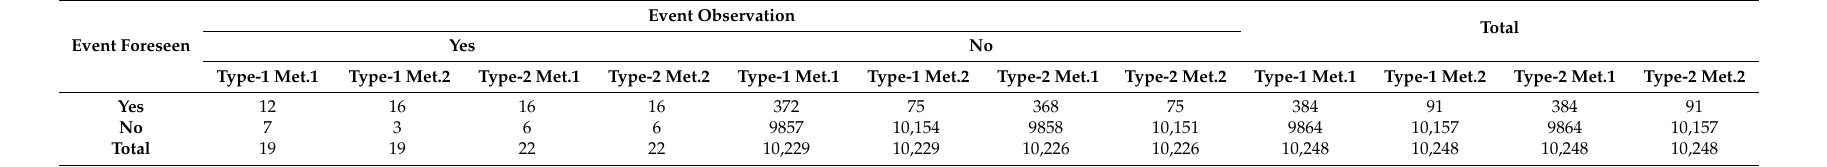
Table 6. Contingency table for upward ramps detected with Methodologies 1 and 2 for Summer.